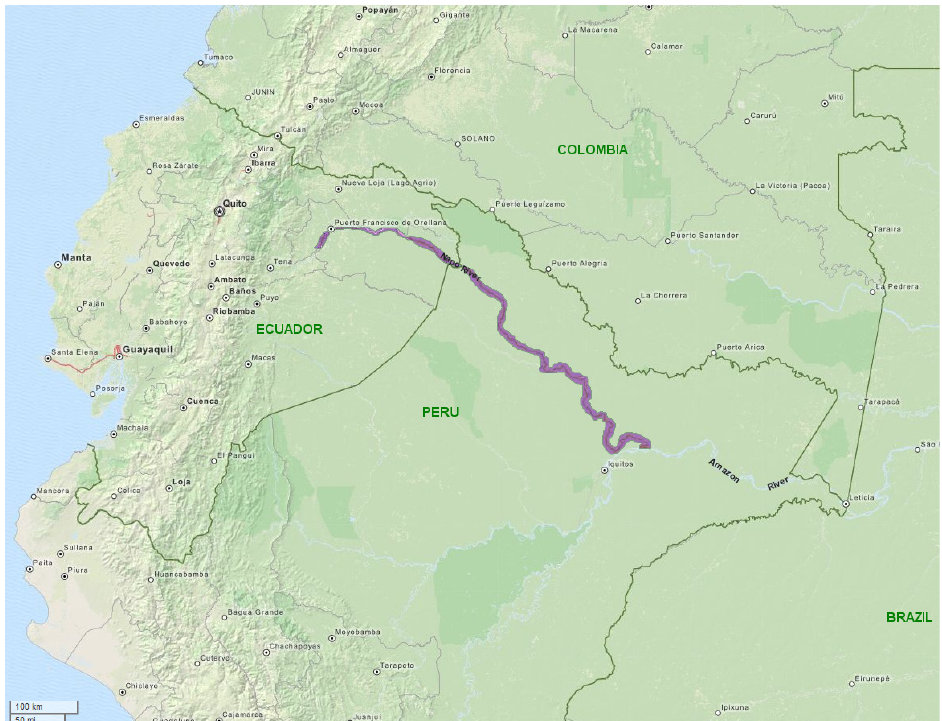
Fig. 1: Western Amazonia, showing the research area of the project (purple). (© OpenStreet- Map contributors CC BY-SA